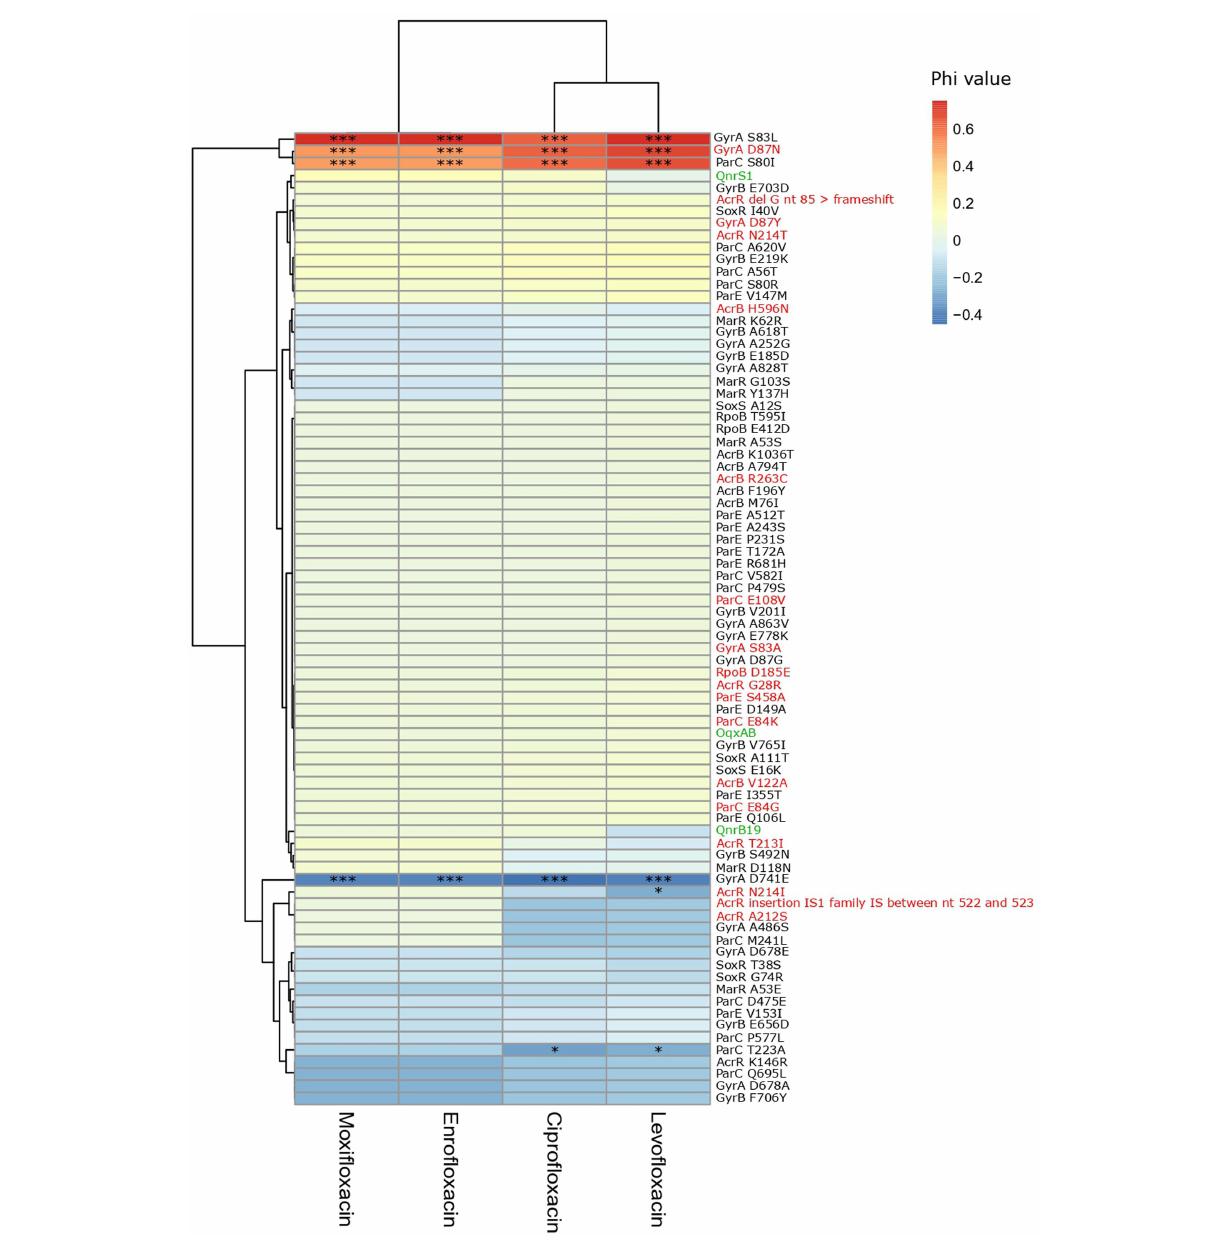
FIGURE 4 Heatmap of the association between the presence of PMQR genes and mutations and fluoroquinolone non-susceptibility. Colors represent the phi values. Negative phi values represent negative associations, positive values represent positive associations between the genes/mutations and the non- susceptibility to the fluoroquinolone antibiotics. PMQR genes are indicated in green, predicted amino acid changes that are likely deleterious for the protein function according to SIFT are indicated in red. *( p < 0.05), *** ( p < 0.001) (Chi-squared test). IS: insertion sequence, nt: